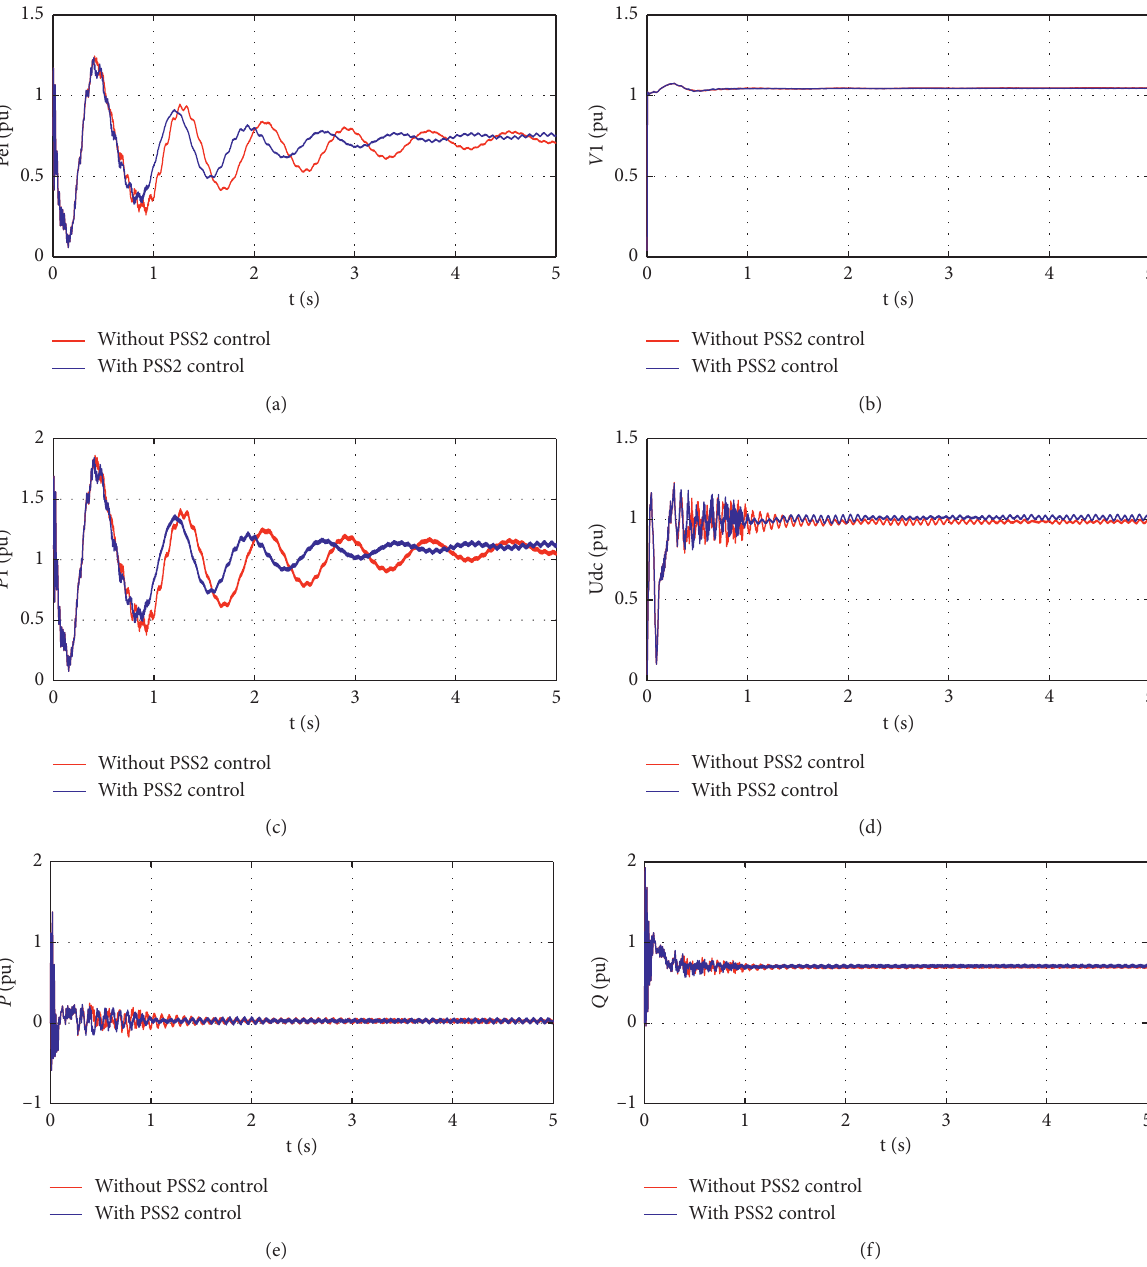
Figure 8: Dynamic response of the system before and after adding PSS2 in the case of wind speed disturbance. (a) The electromagnetic torque of synchronous generator 1. (b) The voltage of synchronous generator 1. (c) The active power of synchronous generator 1. (d) The direct current voltage of HVDC. (e) The active power of VSC1. (f) The reactive power of